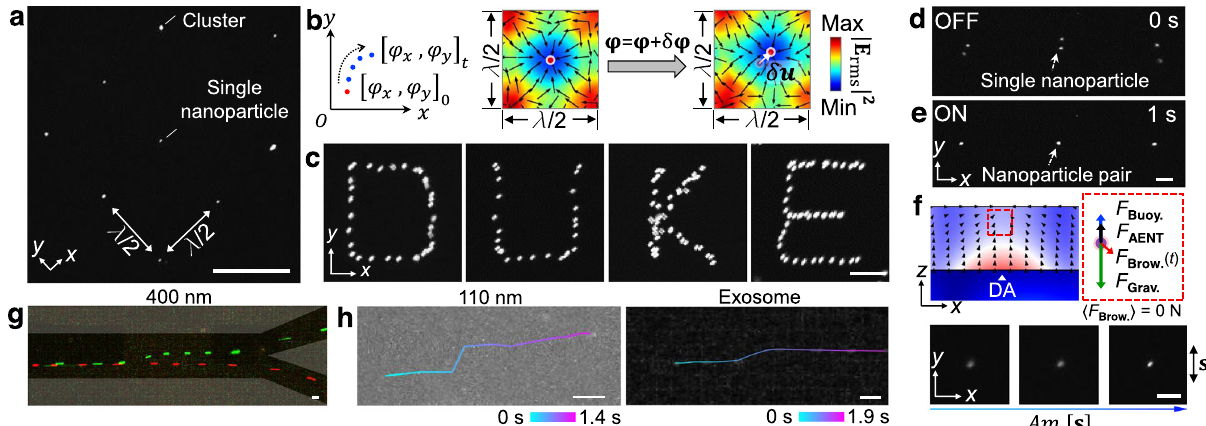
Fig. 6 AENT enables nanomanipulation with single-particle precision. a 2D lattices containing single 400nm polystyrene beads in several trapping wells. b Principle of 2D nanomanipulation by tuning the phases of the orthogonal standing waves. c Stacked fl uorescence images showing a 400nm polystyrene particle can be translated along complex paths as letters “ D ” , “ U ” , “ K ” , and “ E ” . d , e Reversible pairing of single 400nm beads using 2D electric fi elds. f Schematic force analysis and levitation of a single 400 nm bead as the amplitude of the standing wave increases. F AENT acoustoelectronic force, F Buoy. buoyant force, F Grav. gravitational force, F Brow. Brownian forces, DA displacement antinode. The label “ s ” with bi-directional arrows indicates the direction of standing waves. g , h De fl ection of single nanoparticles in continuous fl ow using narrow acoustoelectronic wave beams. g De fl ecting a 400 nm particle in a bifurcated channel. A single 400nm particle fl ows to the lower outlet by-default (AENT off, red pseudo-color) or can be de fl ected to the upper channel when AENT is on (green pseudo-color). Gray shadings: PDMS wall. h De fl ection of single 110 nm polystyrene bead, and single exosome particle in continuous fl ow. The time-elapse trajectories are plotted over the composite image, where the color scales indicate the elapsed time. Time intervals: 100 ms. Scale bars: a : 60 μ m; c – f : 15 μ m; g , h : 20 μ